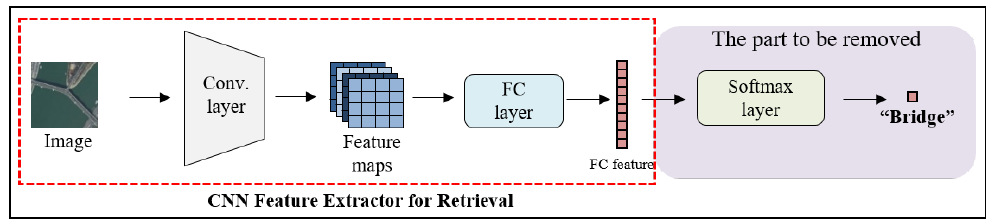
Figure 3. Overview of the conventional CNN architecture used in image retrieval. The network is trained to classify labels with learning high-level features of the contents. Those features are then utilized to retrieve the